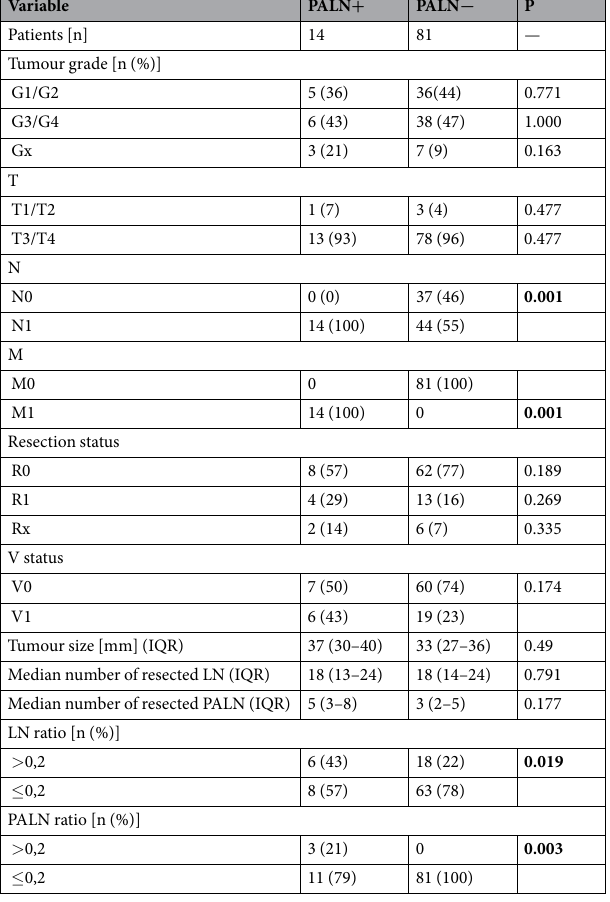
Table 2. Histopathological tumour characteristics. Abbreviations: IQR, interquartile range; LN, lymph node; PALN, para-aortic lymph nodes.